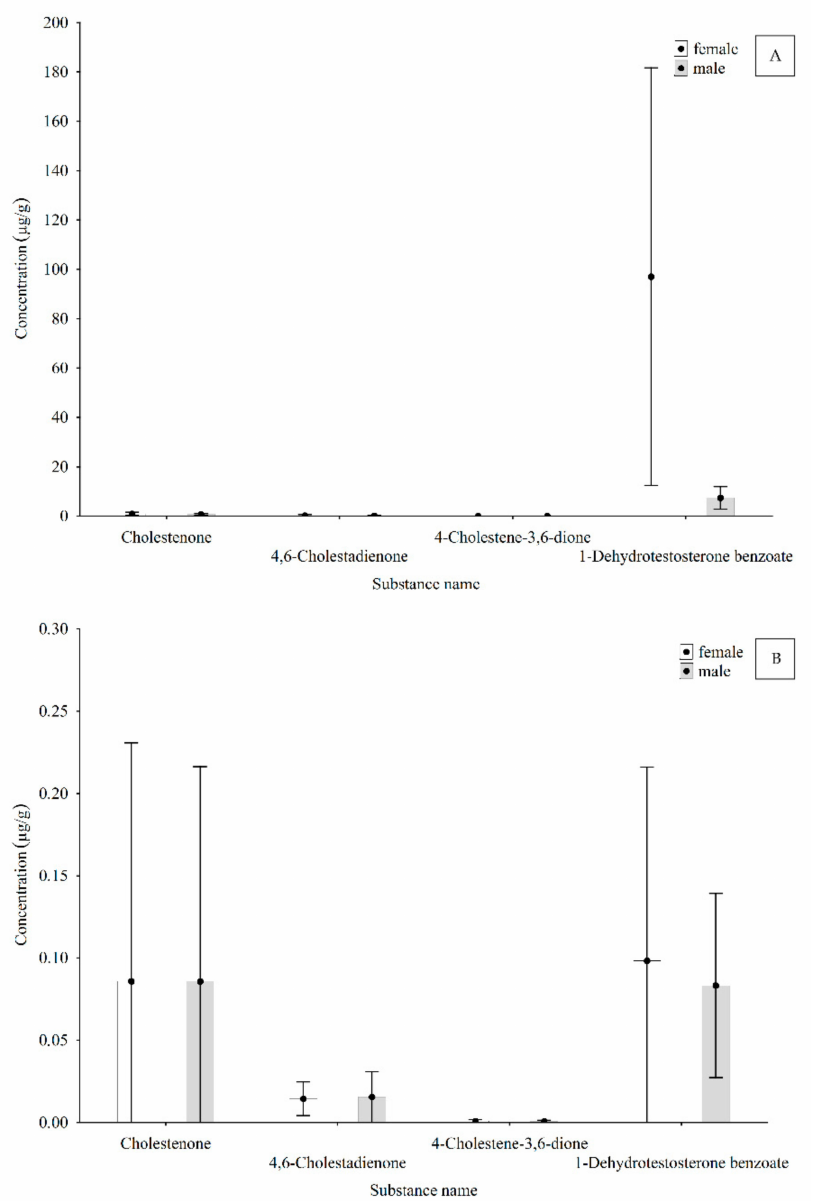
Figure 5. Mean ( ± SD) concentration of sterol compounds (method without KOH derivation) dif- ferentiating the sexes of I. typographus ( A ) and P. chalcographus ( B ) isolated from adult specimens (the number of samples for each insect species was N = 12). The names of some substances have been expressed as synonyms. 1-Dehydrotestosterone benzoate = 17 β -Hydroxyandrosta-1,4-dien-3- one